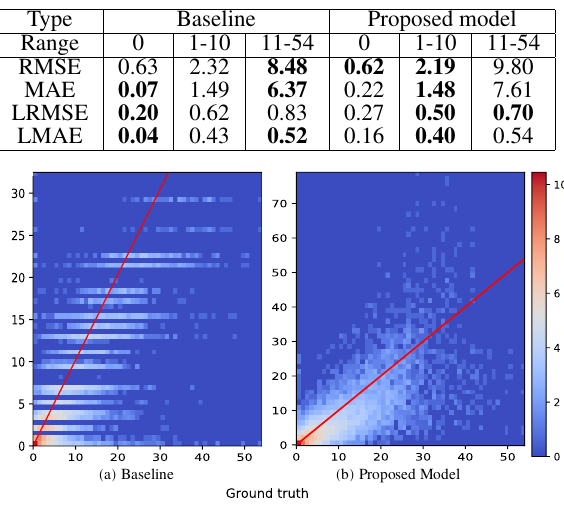
Figure 5. Scatter plots (in log scale) of the counting prediction for the (a) baseline and (b) proposed model. The red lines indicate a theoretical perfect